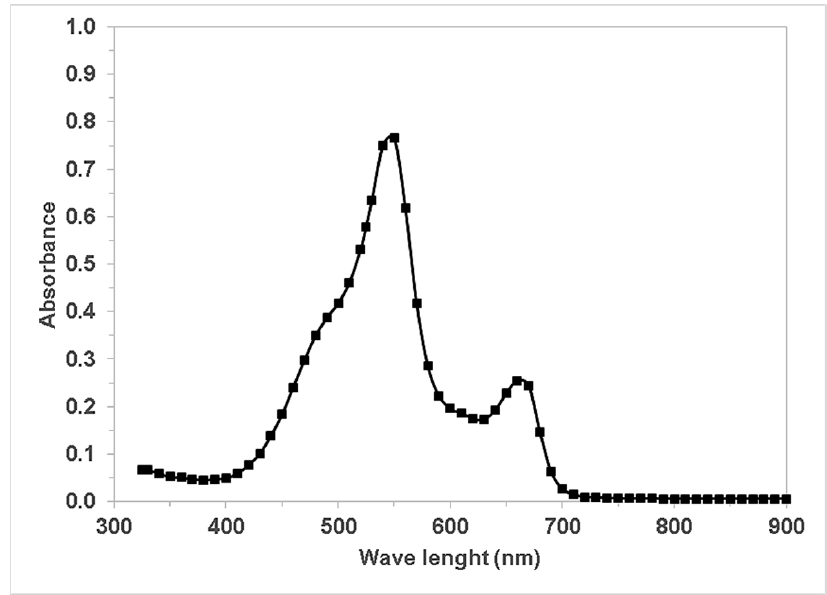
Figure 1. UV–Vis spectrum of the clinical laboratory wastewater diluted sample. Undiluted sample transmi tt ance is in the order of 0.025%, meaning only a small frac-